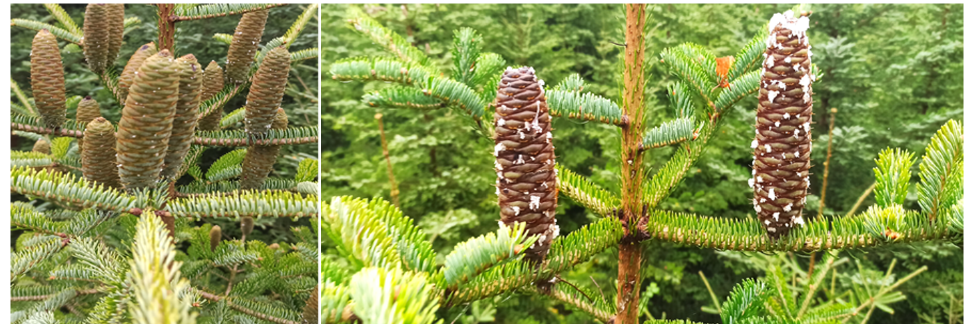
Figure 2. Cones of silver fir trees from which seeds were collected in September 2021 (photo K. Wiłamowski). The cones ranged in length from 8.5 to 18.2 cm and width from 3.1 to 4.8 cm.